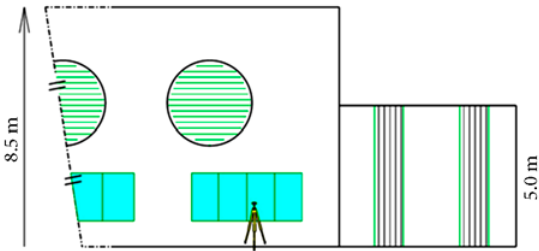
Fig. 1. Location of multipurpose sports hall VSB-TUO + the geometrical base